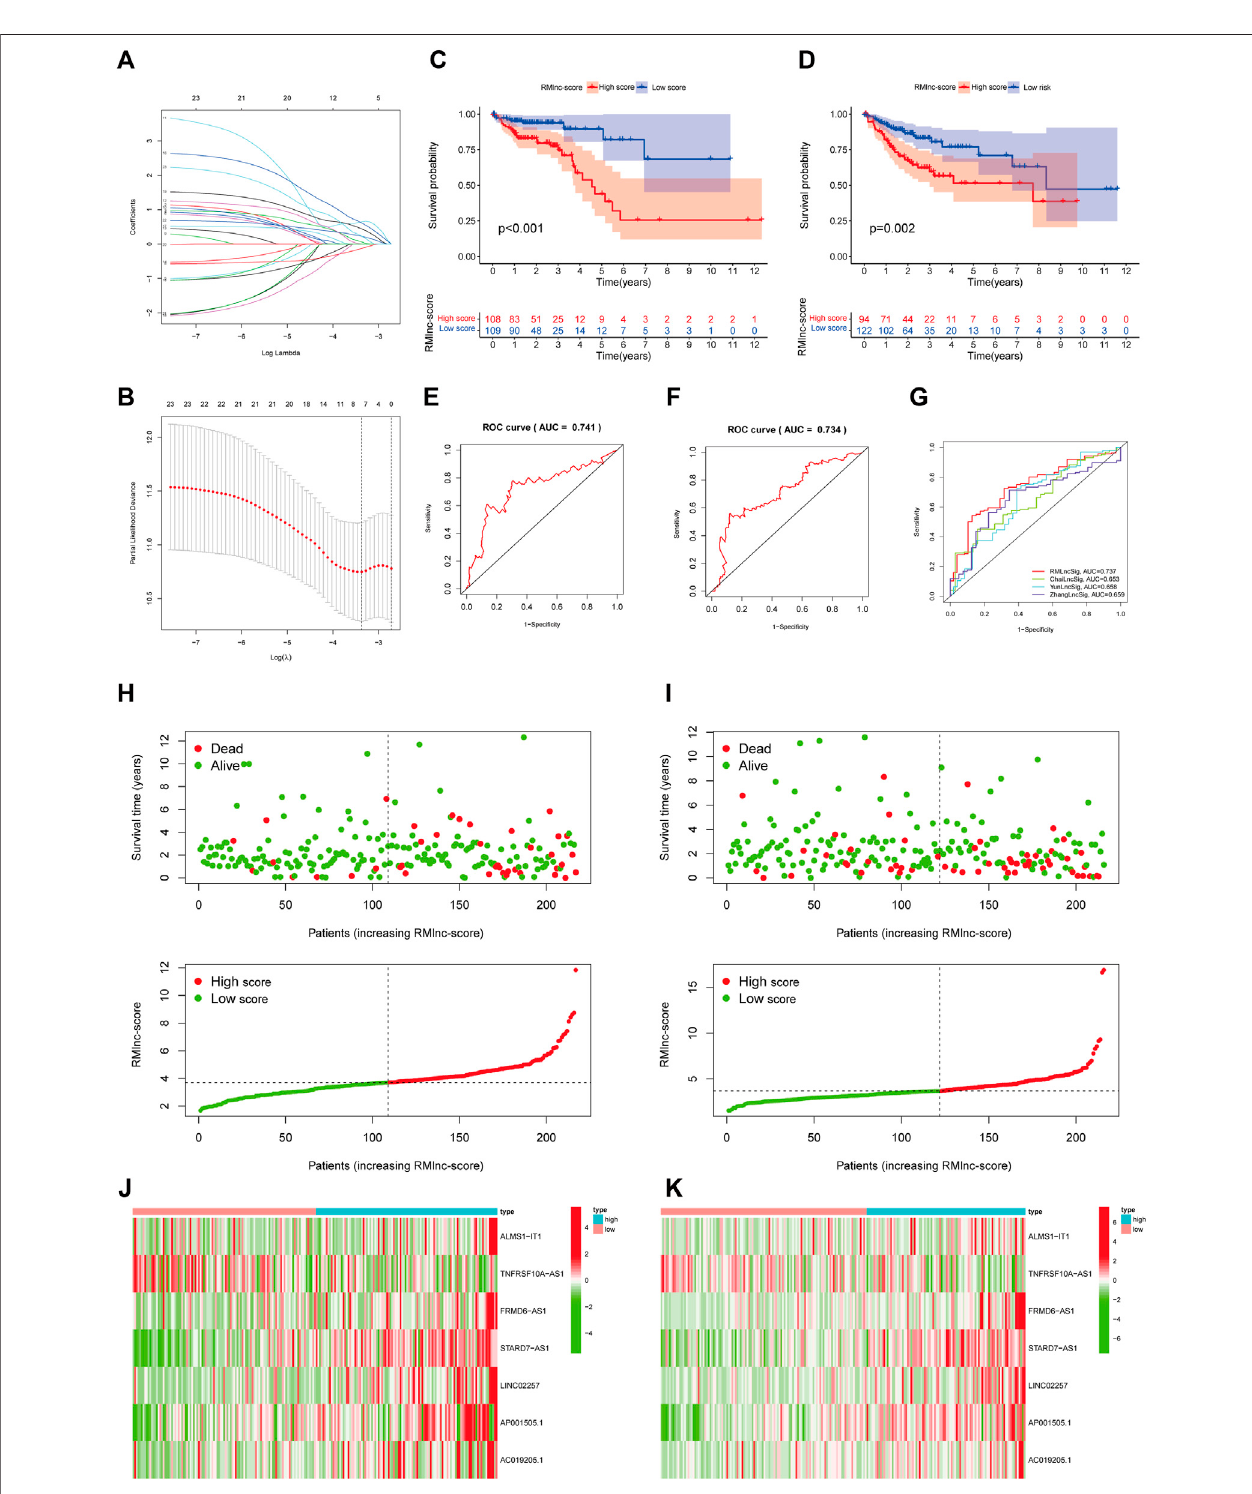
FIGURE 6 | RNA methylation-related lncRNA prognostic signature. (A,B) Seven optimal RNA methylation-related lncRNAs were found using the least absolute shrinkage and selection operator (LASSO) cox regression. (C,D) Kaplan-Meier curves for overall survival in the training and test sets. (E,F) ROC curves were used to predict the 5-years survival ofpatients inthe training and test sets.The AUC was0.741 in thetraining set and 0.734 inthe test set. (G) Comparison ofRMlinc-scorewith otherprognosticevaluation models. (H,I) SurvivalstatusandRMlinc-scorecurves inthetrainingandtestsets. (J,K) Heatmap ofRNAmethylation-relatedlncRNAs expression in the training and test